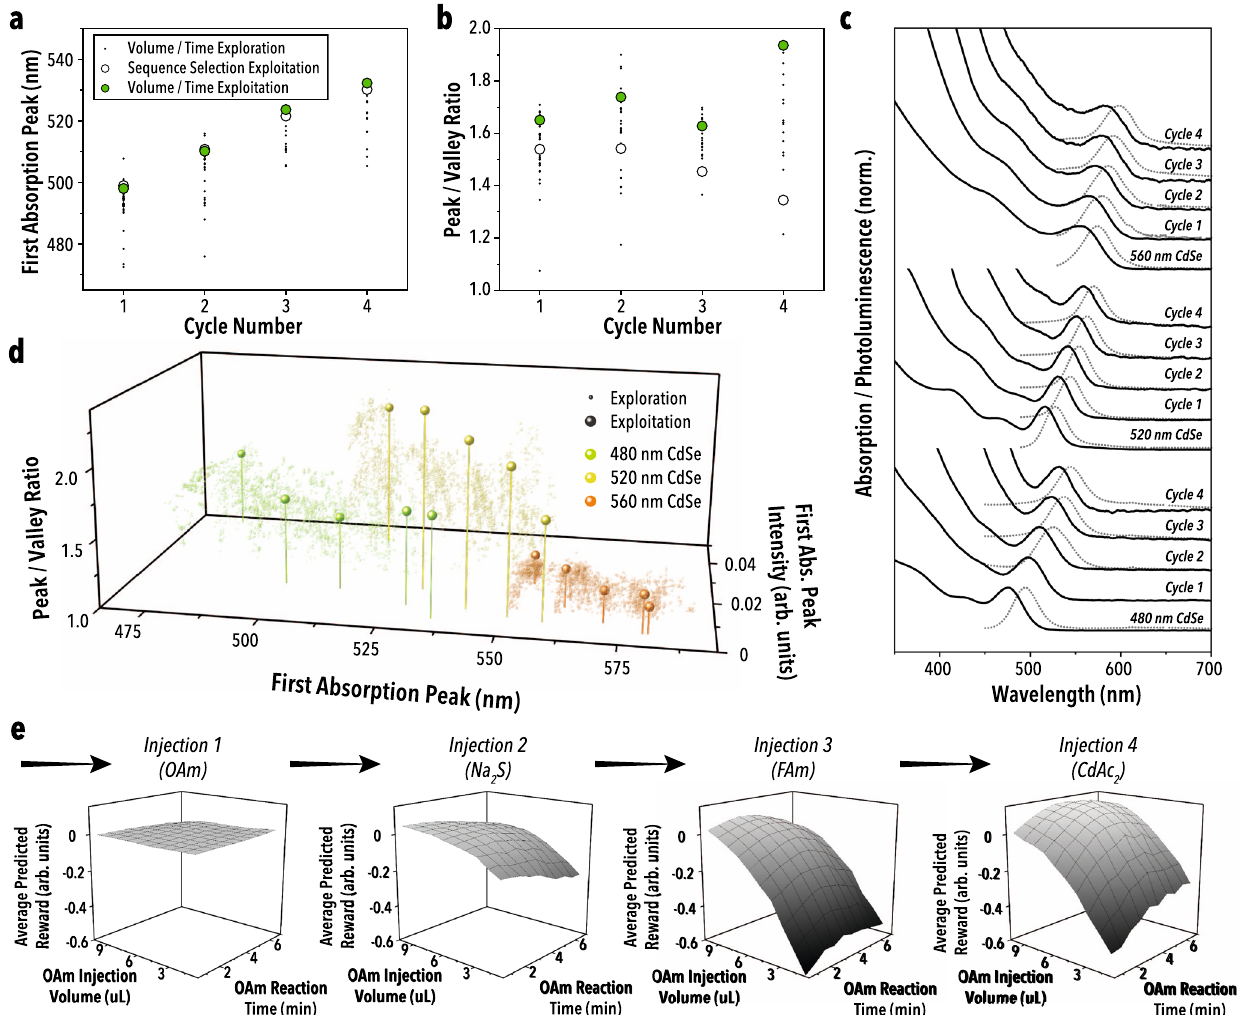
Fig. 4 | Volume and time optimization campaign results of AlphaFlow. a First absorption peak wavelength and peak-to-valley ratio ( b ) as a function of the full cALD cycle number for the volume and time exploration and exploitation and the cALD chemistry exploitation. c Absorption and photoluminescence spectra for the complete cALD cycles of the volume and time exploitation runs on each ofthe three starting CdSe nanoparticle sizes studied. d Output parameter space for the exploration and exploitation of the three CdSe nanoparticle sizes. e